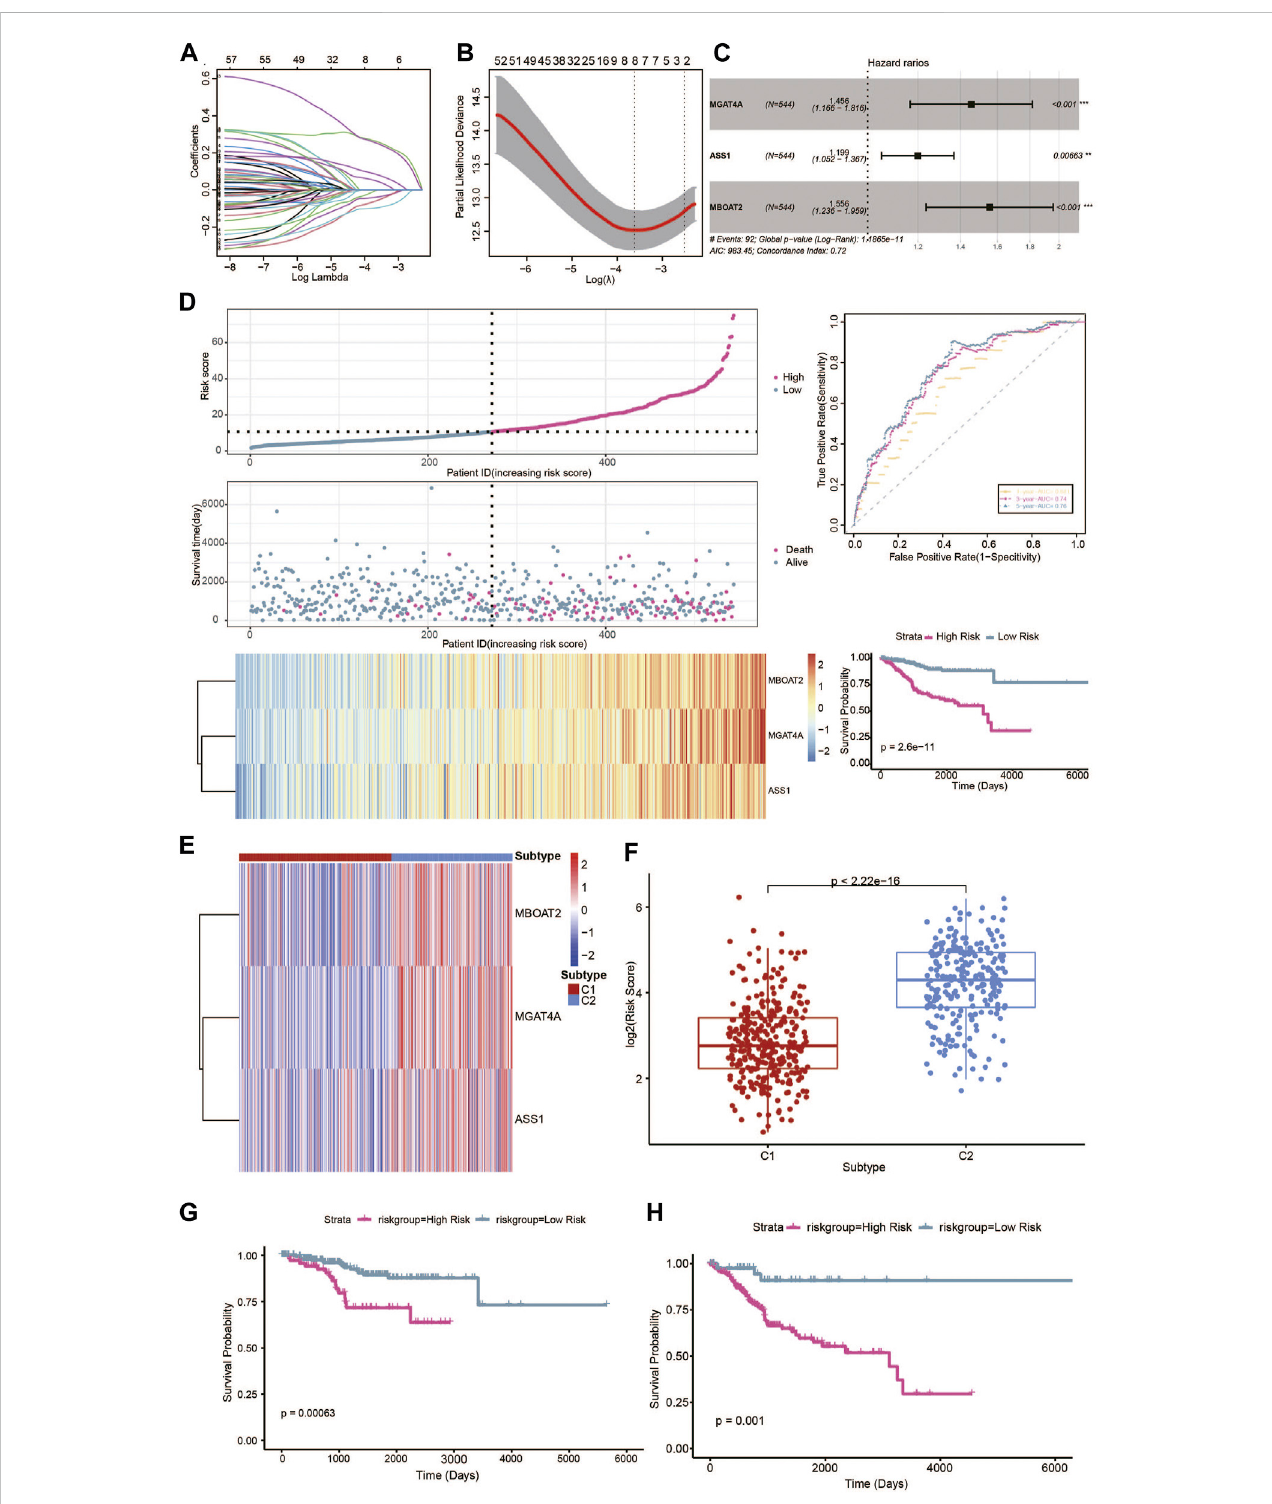
FIGURE 7 Prognostic risk model based on metabolic characteristic genes of the metabolic subtypes in UCEC. (A) LASSO coef fi cients of the metabolic genes. (B) Cross-validation of gene selection using 1-SE criteria in the LASSO regression analysis. (C) The forest plot of multivariate Cox regression analysis. (D) The predictivevalue ofgene signature inthetraining dataset. (E) Heatmap of theexpressionlevels of signature genes in themetabolicsubtypes. (F) Distribution of risk scores in the UCEC metabolic subtypes. (G) Survival analysis of the metabolic-related signature in the UCEC metabolic C1 subtype. (H) Survival analysis of the metabolic-related signature in the UCEC metabolic C1